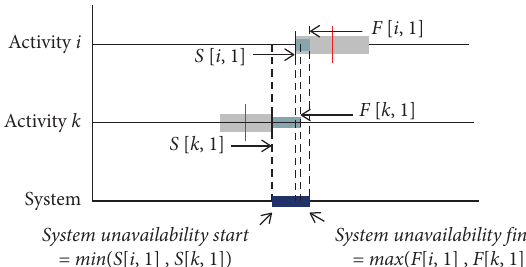
Figure 3: Example of a grouping scheme possible by relaxing the start restriction on grouped